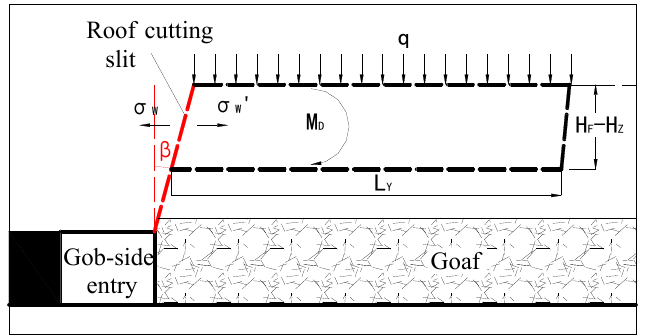
Figure 5. Schematic of the mechanical model corresponding to the cutting cantilever beam.